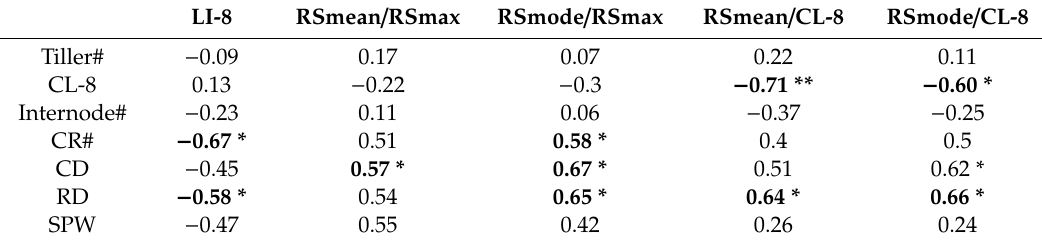
Table 5. Correlations between morphological traits (number of crown roots (CR#), crown diameter (CD), root diameter (RD), and single-plant weight (SPW)) and four approaches to lodging index estimates, i.e., two based fully on remote sensing (RSmean / RSmax and RSmode / RSmax) and two based on remote sensing vs. culm length (CL) (RSmean / CL and RSmode / CL) in the 2019 experiment. Correlations with ground-based lodging index estimates recorded at week 8 after emergence (LI-8) are presented as references. LI-8 RSmean / RSmax RSmode / RSmax RSmean / CL-8 RSmode / CL-8 Tiller# − 0.09 0.17 0.07 0.22 0.11 CL-8 0.13 − 0.22 − 0.3 − 0.71 ** − 0.60 * Internode# − 0.23 0.11 0.06 − 0.37 − 0.25 CR# − 0.67 * 0.51 0.58 * 0.4 0.5 CD − 0.45 0.57 * 0.67 * 0.51 0.62 * RD − 0.58 * 0.54 0.65 * 0.64 * 0.66 * SPW − 0.47 0.55 0.42 0.26 0.24 *, ** Significant at P < 0.05 and 0.01,